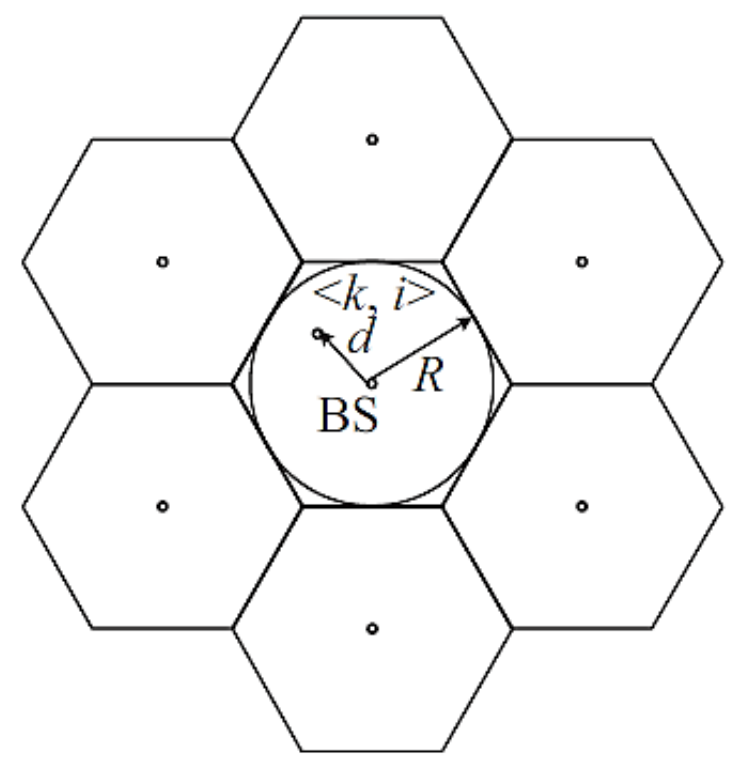
Figure 7. Simulation scenario of massive MIMO system of seven cells.